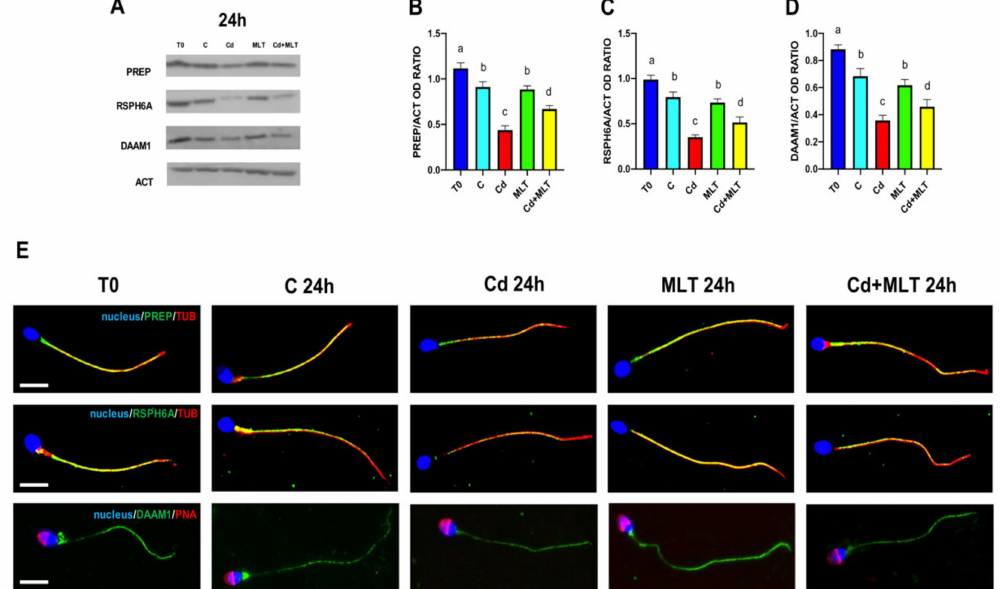
Figure 5. Western Blot (WB) and immunofluorescence (IF) analysis of PREP, RSPH6A, and DAAM1 of sperm samples incubated with Cd and/or MLT for 24 h. ( A ): WB analysis showing PREP (80 kDa), RSPH6A (80 kDa), DAAM1 (112 kDa) and β -actin (42 kDa) protein levels in SPZ treated with Cd and/or MLT. ( B – D ): Histograms showing the relative protein levels of PREP ( B ), RSPH6A ( C ), and DAAM1 ( D ), respectively. Data were normalized with β -actin and reported as OD ratio. Values are expressed as means ± SEM from 15 samples divided into the five groups, including the initial control (T0). A vs. b p < 0.05; a vs. c p < 0.001; a vs. d p < 0.01; b vs. c p < 0.01; b vs. d p < 0.05; c vs. d p < 0.01. ( E ) IF analysis of PREP (green, upper panel), RSPH6A (green, middle panel), and DAAM1 (green, lower panel) in SPZ treated with Cd and/or MLT for 24 h. Red represents α -tubulin in the upper and middle panels, and acrosome, marked with PNA lectin, in the lower panel. Slides were counterstained with DAPI-fluorescent nuclear staining (blue). Scale bars represent 10 µ